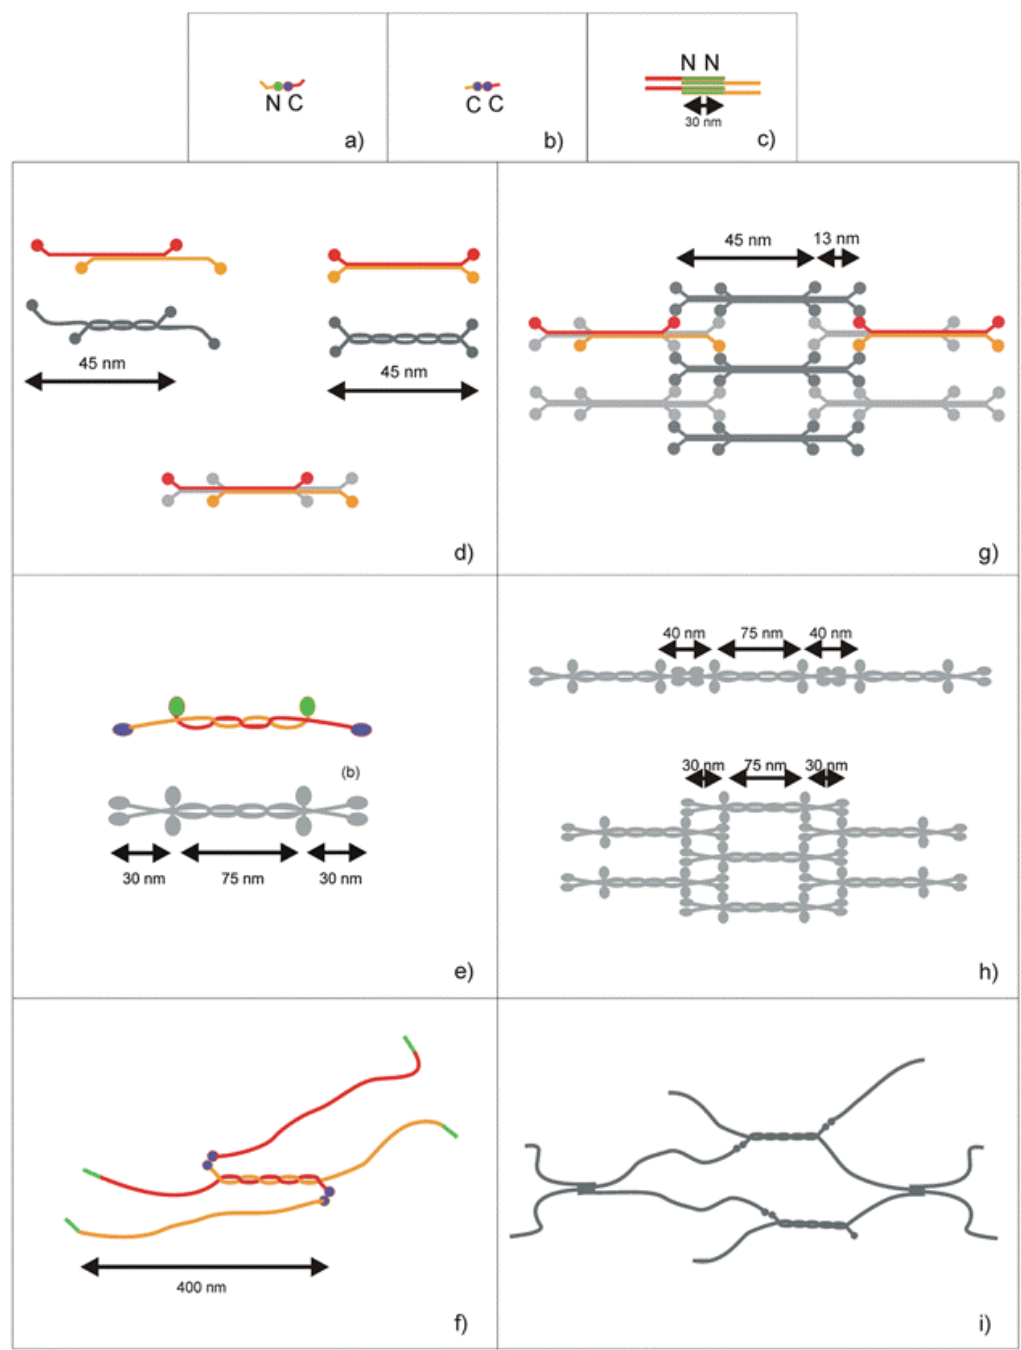
FIGURE 11. Summary of the structural characteristics of collagen IV, VI, and dogfish egg case collagen. These collagens can interact linearly end to end through their N- and C-terminals (represented in green and purple, respectively). Dogfish egg case and collagen VI interactions are represented in (a) , and collagen IV interactions in (b) and (c) . In addition, they all interact laterally to form antiparallel dimers: in (d) the dogfish egg collagen interactions are represented. At present, it is not known whether monomers associate with a 15-nm axial shift to form dimers, or if an axial shift occurs between already formed tetramers. Although the resolution reached does not allow a direct visualisation, it is conceivable that supercoiling occurs between monomers. Lateral interactions of collagen VI are represented in (e) and those of collagen IV in (f). Networks are formed when linear and lateral interactions take place (the dogfish egg case collagen network is represented in (g) , collagen VI network in (h) and collagen IV network in (i) . Collagen VI is also capable of forming long chains when tetramers associate linearly (h,